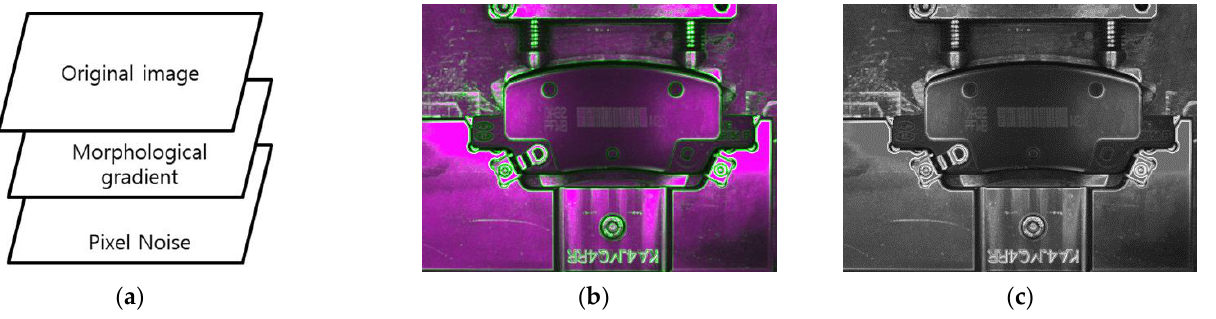
Figure 9. ( a ) One of the channel structures proposed in this study. ( b ) Color image produced by using data augmentation. ( c ) Grayscale images used to verify that there are effects other than the increased number of data.